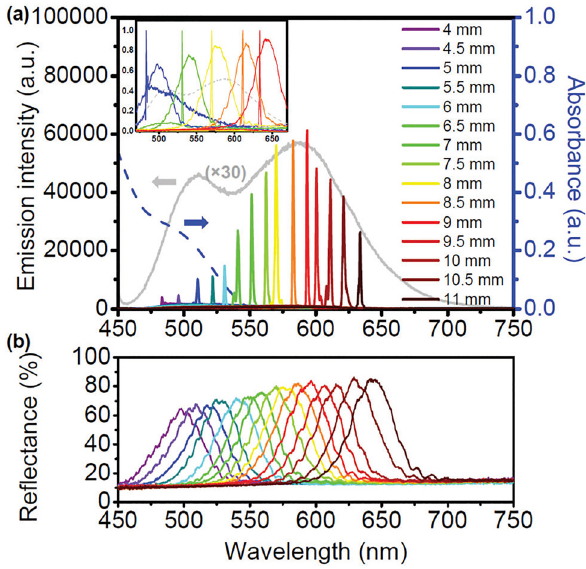
Figure6: (a)LasingemissionspectraoftheDDNLC-refilledgradient- pitched enantiomorphic template sample at E = 4.56 mJ per pulse, measured at positions from x = 4 mm to x = 11 mm, at T = 48 ° C. The inset in (a) shows the re fl ection bands with the associated normalized lasing lines measured at fi ve selected positions in the DDNLC-re fi lled gradient-pitched enantiomorphic template sample. Thegreyandbluedottedcurvesin(a)arethemeasured fl uorescence emission and absorption spectra of the DDNLC, respectively, in the isotropic state for reference. (b) Corresponding re fl ection spectra of the sample measured at positions from x = 4 mm to x = 11 mm at 48 ° C